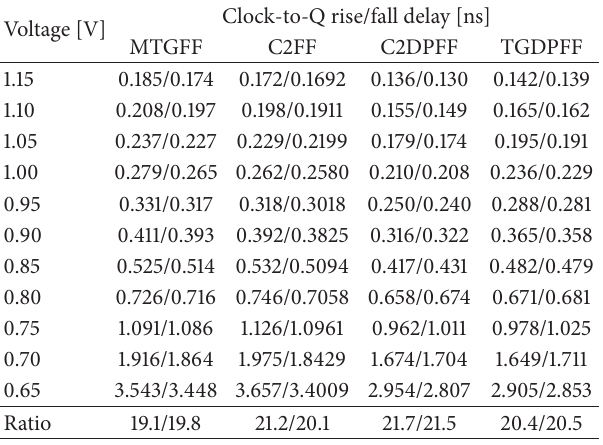
Table 1: Conventional FFs versus proposed DPFFs (measured). Param.